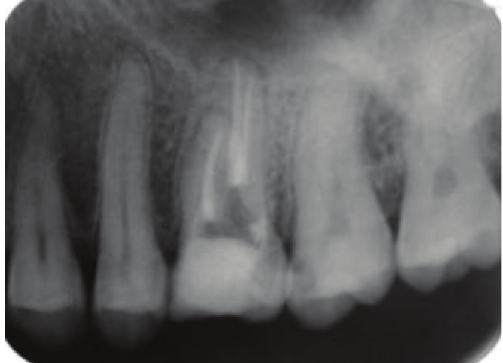
Figure 4: Postoperative